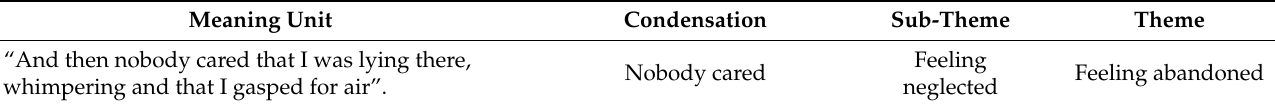
Table 2. Example of the structural analysis.